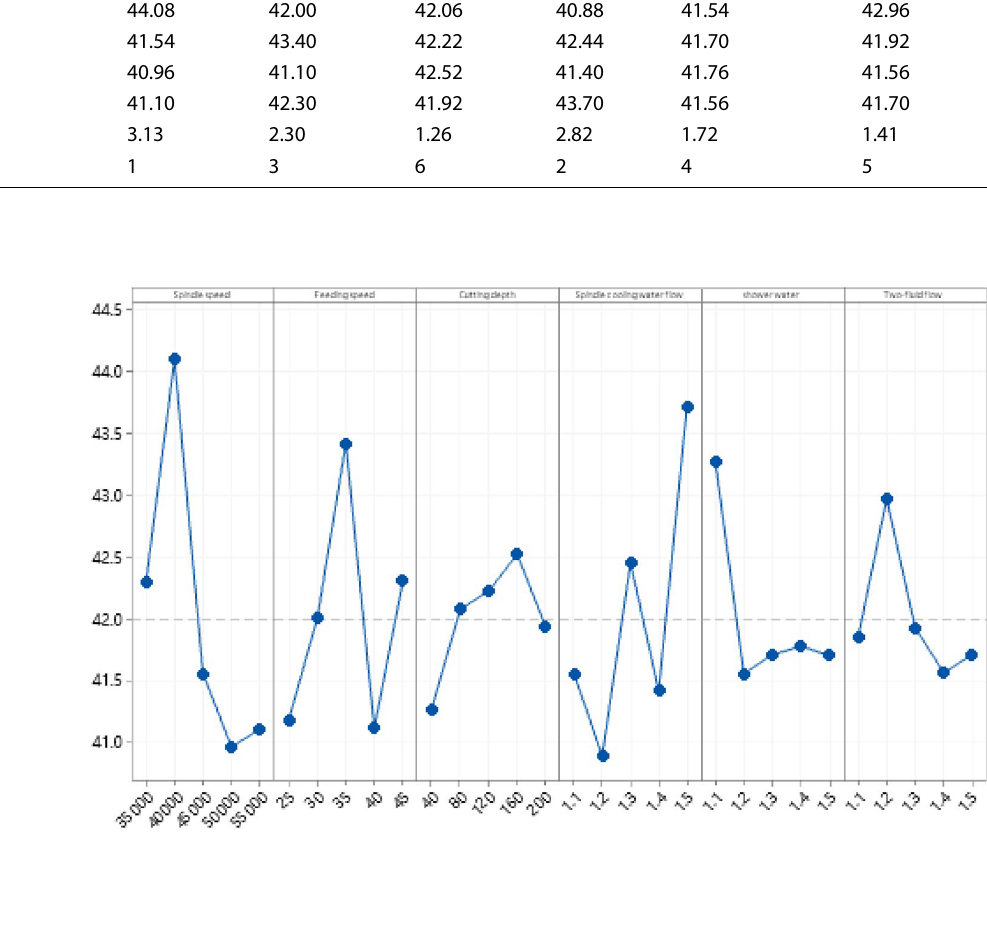
Table 5 Table of regression